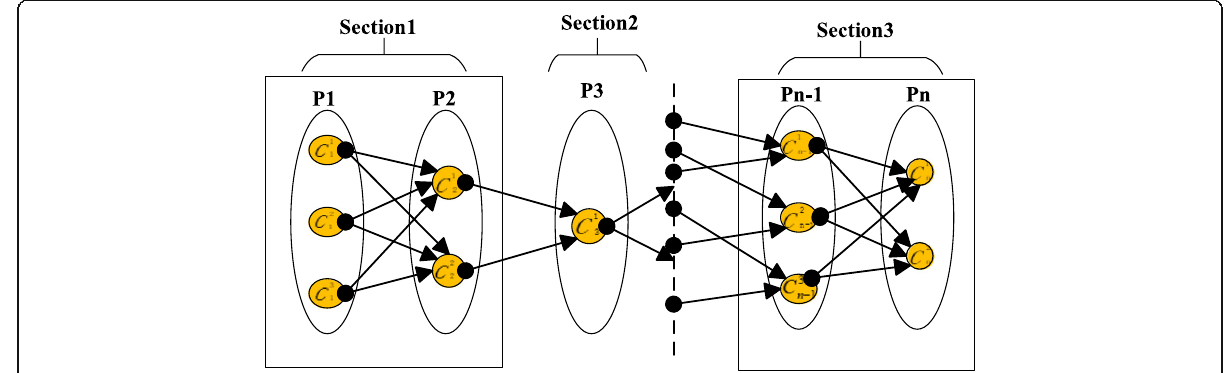
Fig. 9 Division graph with a single potential